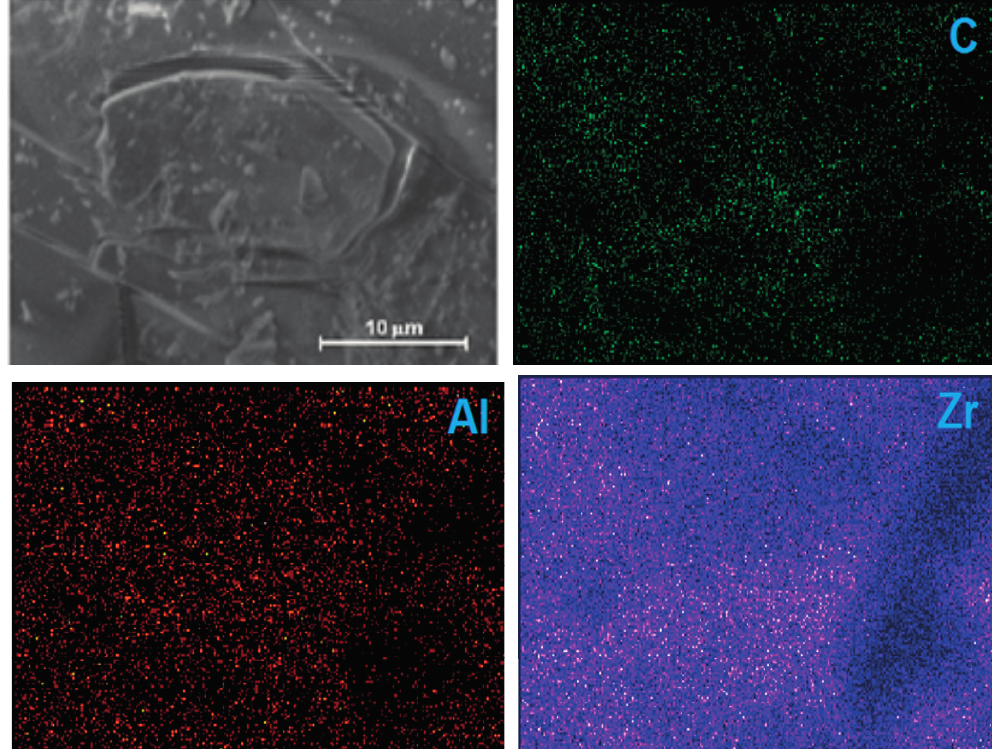
Figure 7. ( a ) SEM image of a ZrO 2 xerogel with the (OH)AlTSPc species trapped inside the pores and treated at 125 °C, and ( b ) EDS mapping images of carbon C, aluminum (Al) and zirconium